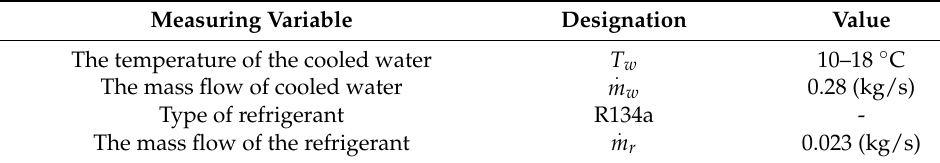
Table 4. The initial